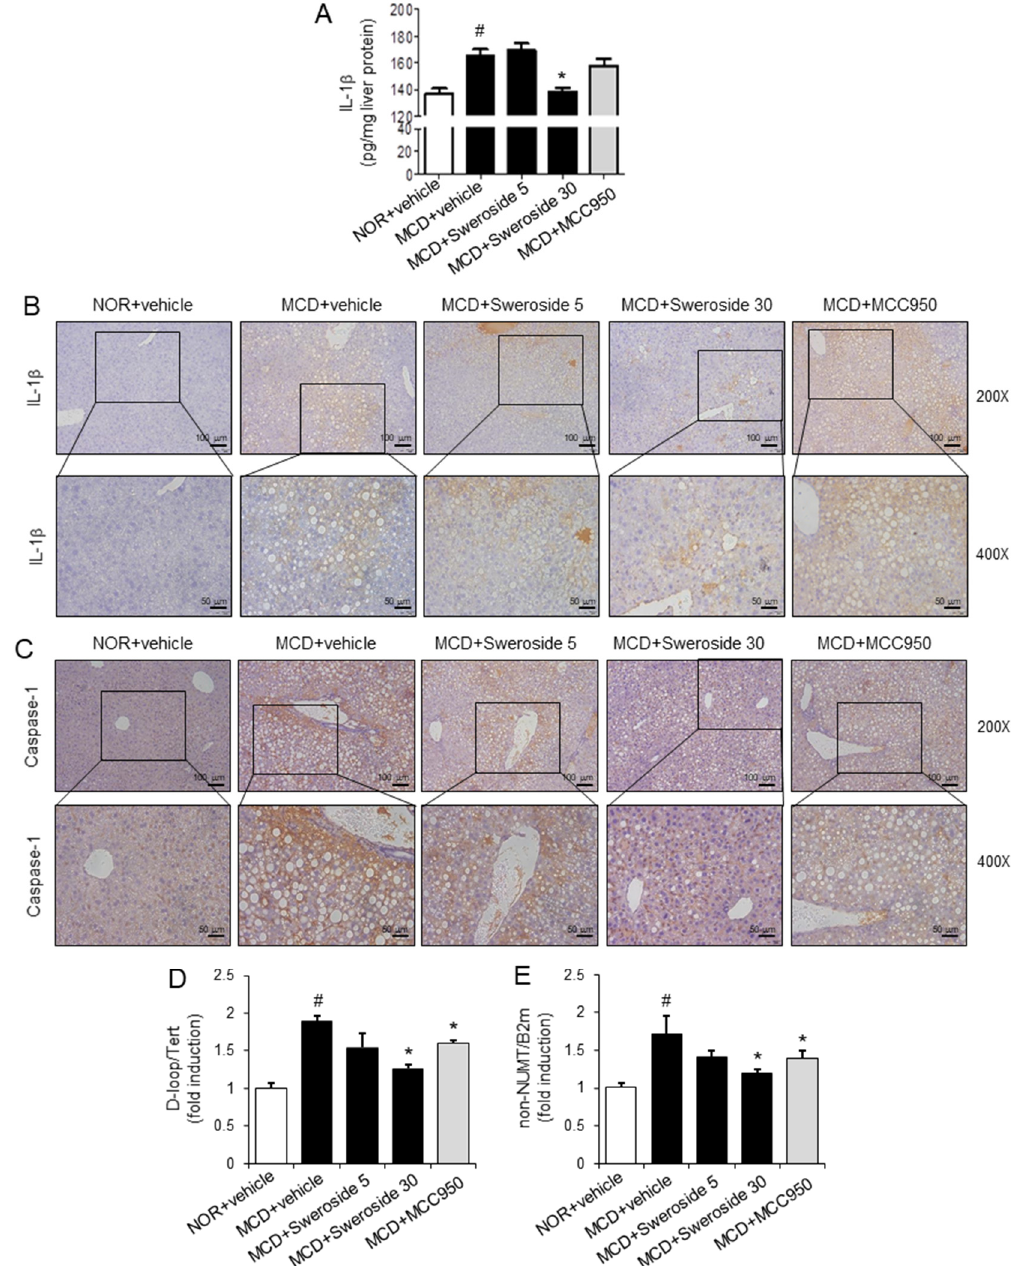
Figure 6. Sweroside suppresses the activation of the hepatic NLRP3 inflammasome in mice fed an MCD diet. Samples were obtained from the mice described in Figure 3. ( A ) IL-1 β protein levels in liver homogenates were measured by ELISA. The values represent means ± SEM ( n = 8). ( B , C ) Representative immunohistochemistry staining for IL-1 β and caspase-1 in the liver (200 × and 400 × ). ( D , E ) Relative total mtDNA amounts in liver tissues were quantified by quantitative PCR with primers specific for the mitochondrial D-loop region (D-loop) or a region of mtDNA that is not inserted in nuclear DNA (non-NUMT). The amount of nuclear DNAs (Tert, B2m) was measured to normalize mtDNA production. The values represent means ± SEM ( n = 4). For A, D, and E, #, significantly different from NOR + vehicle, p < 0.05. *, significantly different from MCD + vehicle, p < 0.05.